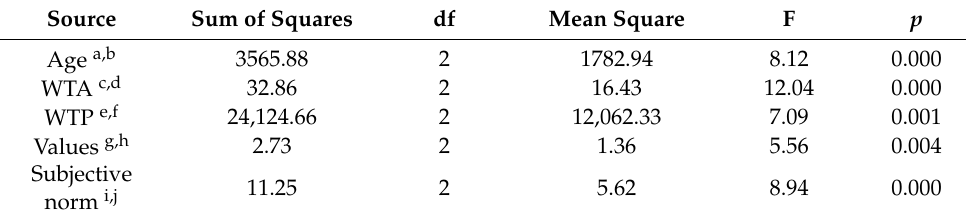
Table A3. ANOVA summary table of differences between segments 1,2 .